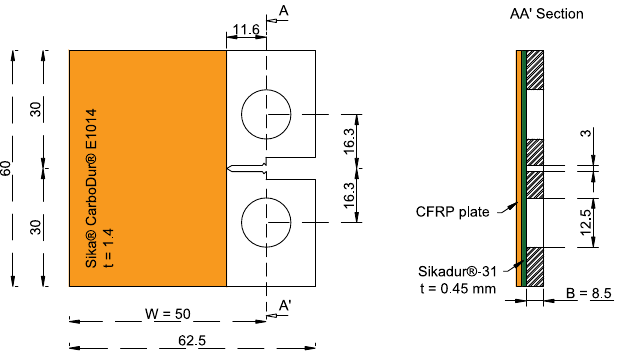
Figure 15. Geometry of CT specimens strengthened with the CFRP patch (all dimensions in